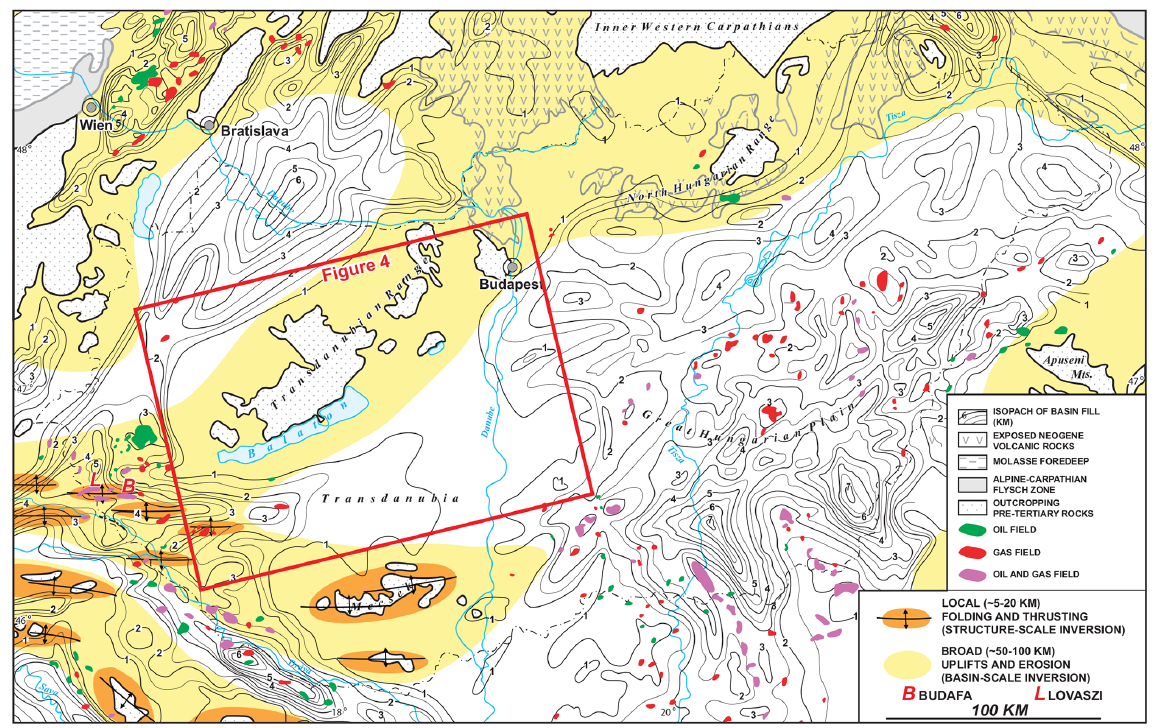
Figure 3. Regional map of the central part of the Pannonian Basin adapted from Tari (1994), who distinguished for the first time between two classes of inversion tectonics in this basin. These two end-member categories of uplift are attributed to regional-scale and local-scale structural inversion tectonics. The map-view pattern of the smaller-scale inverted structures suggests that inversion and uplift are propagating into Pannonian Basin from the SW driven by the Adria plate. The isopach of the basin fill and the location of hydrocarbon fields are based on Tari and Horvath